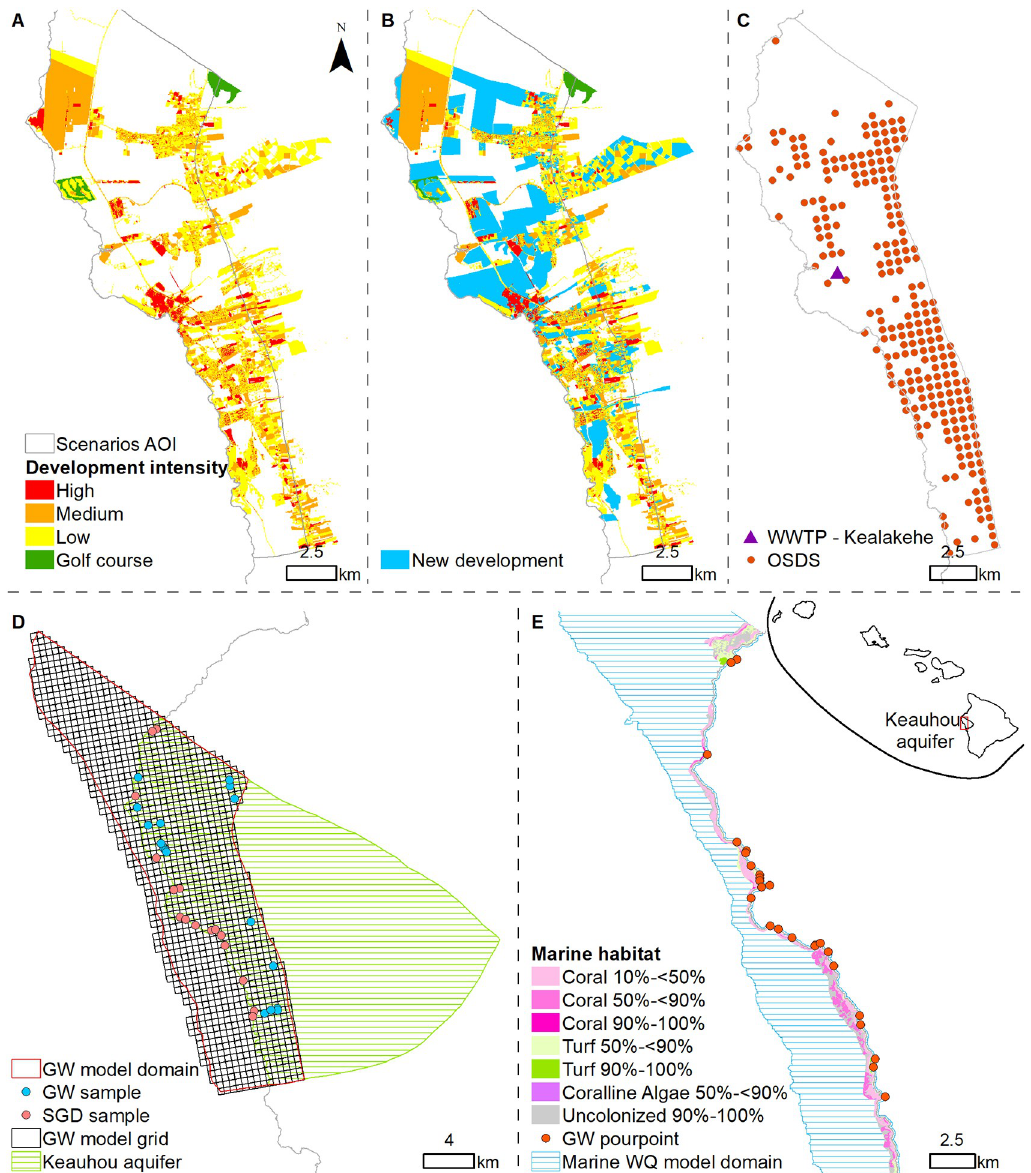
Fig 1. Study site. (A) Current land cover; (B) Future permitted land cover; (C) Location of the WWTP and model grid cells containing one or more cesspools; (D) Groundwater model domain and empirical data; (E) Marine water quality model domain, pourpoints, and marine